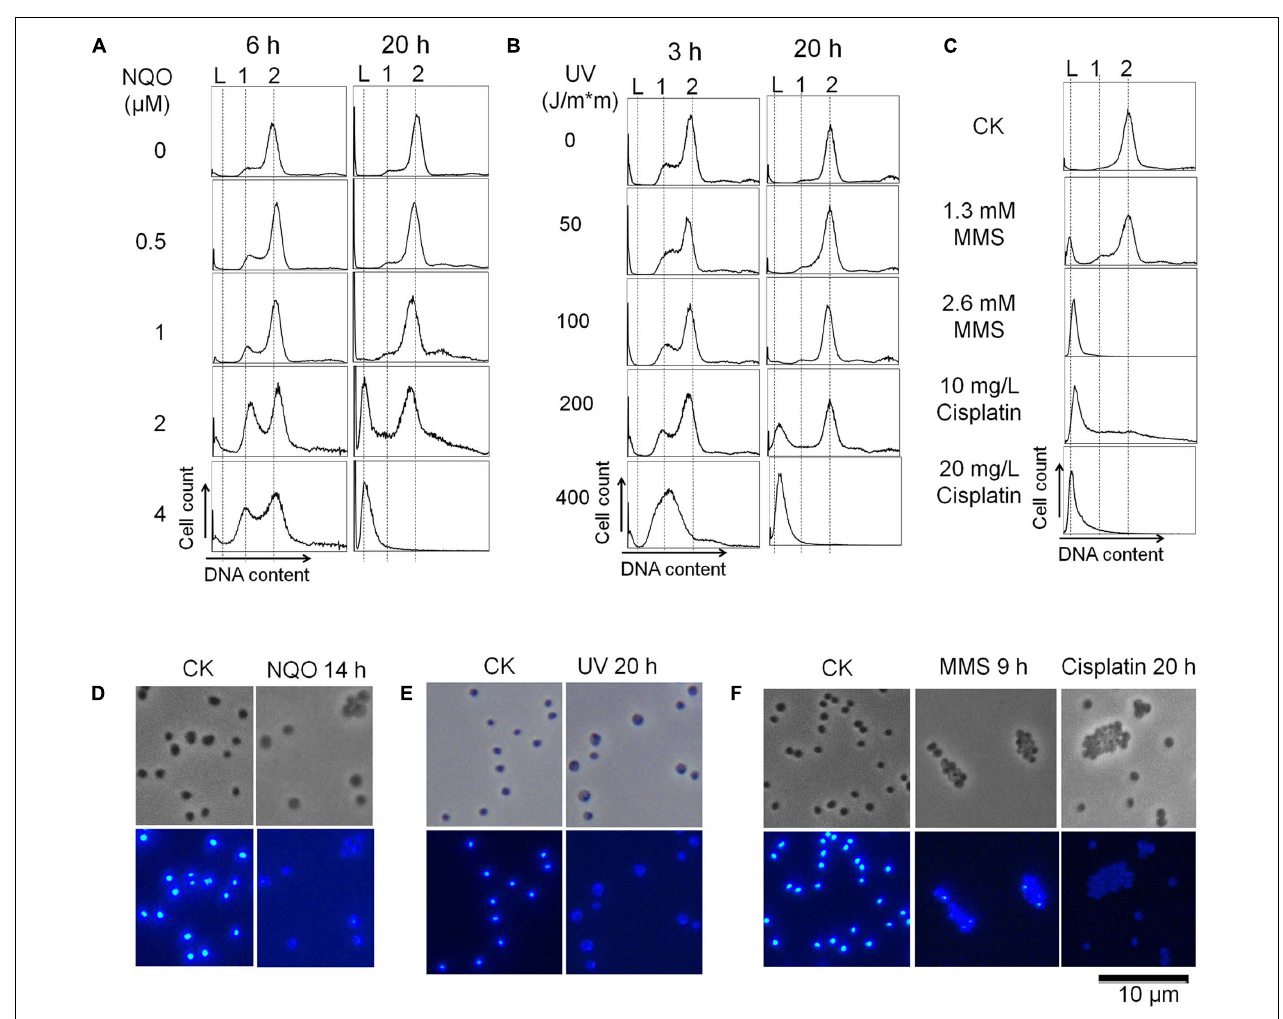
FIGURE 1 | DNA damage agents induce DNA-less cell formation in Sulfolobus islandicus. (A–C) Exponentially growing cultures of the genetic host E233S1 were treated with 4-nitroquinoline 1-oxide (NQO), UV, MMS, and cisplatin with indicated dosages, and then analyzed by flow cytometry. The sampling time was indicated for NQO and UV treatment, while MMS- and cisplatin-treated cultures were analyzed at 20 h during treatment. Horizontal axis (DNA content) and vertical axis (cell count) are shown in liner scale. The DNA-less cells and cells containing one or two copies of genomic DNA are indicated with “L”, “1” and “2”, respectively. The data are the representatives of three independent experiments. (D–F) The cells treated with 4 µ M NQO (D) , 400 J/m 2 UV (E) , 2.6 mM MMS and 20 mg/L cisplatin (F) were analyzed with DAPI-staining and fluorescence microscopy. The sampling time was indicated. Upper panels: phase contrast; lower panels: DAPI. TABLE 1 | Percentage of DNA-less cells in the cultures after treatment of UV, NQO, MMS and cisplatin. UV (J/m 2 ) NQO ( µ M) MMS